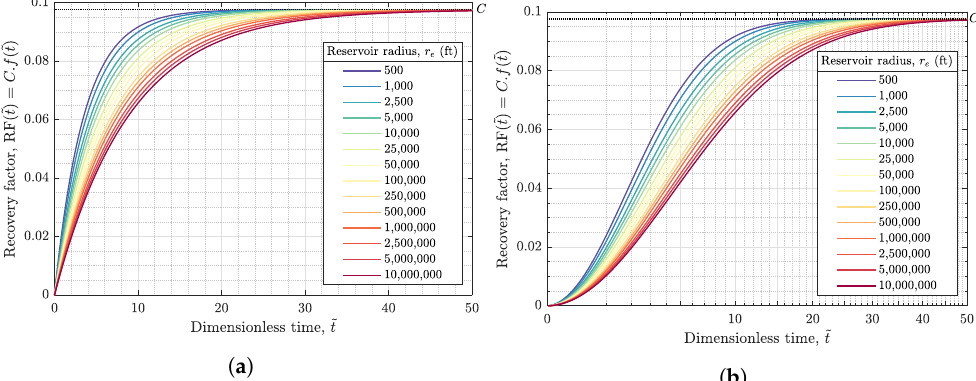
Figure A5. Oil recovery factor for various values of reservoir radius, r e , in ( a ) the linear scale, ( b ) the square root of time